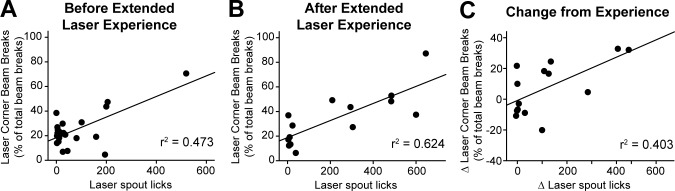
Relationship between the outcomes of two laser self-stimulation tasks.Correlation plots showing the relationship between place-based laser self-administration and active spout-touch laser self-administration, before (A), after (B), and change due to (C) extended laser exposure.